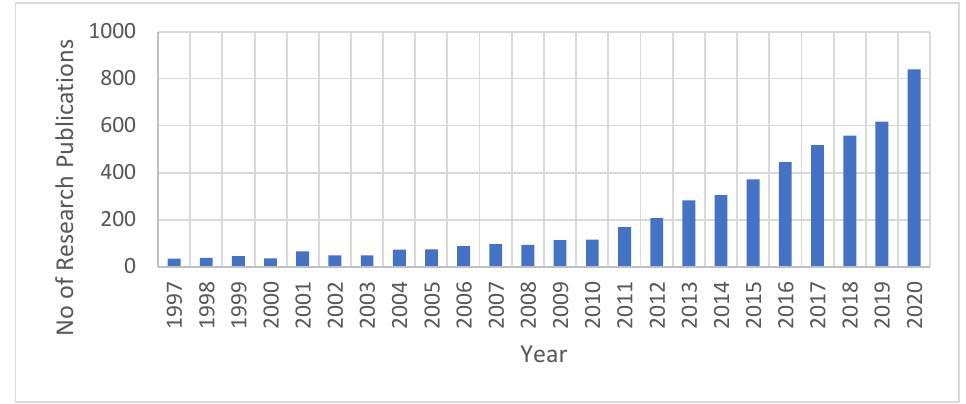
Figure 5. Growth in FO research publications as obtained from the Science Direct database.